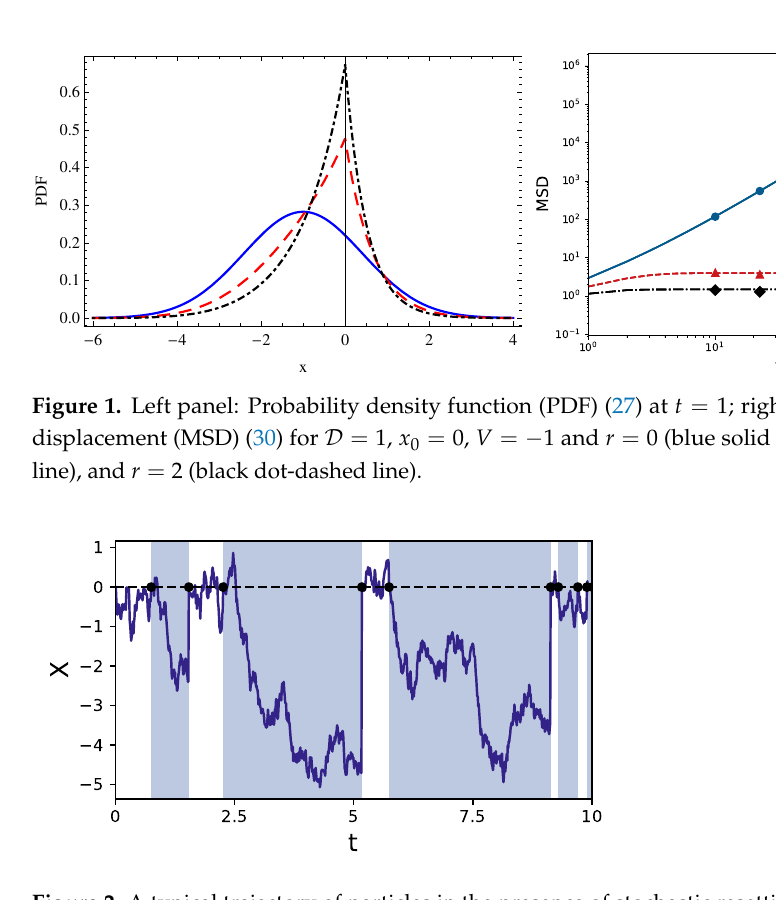
Figure 2. A typical trajectory of particles in the presence of stochastic resetting to the initial position x 0 = 0, for r = 1, D = 1, and V = − 1. The resetting events are represented by black dots. Dashed regions are introduced for these resetting events to be more